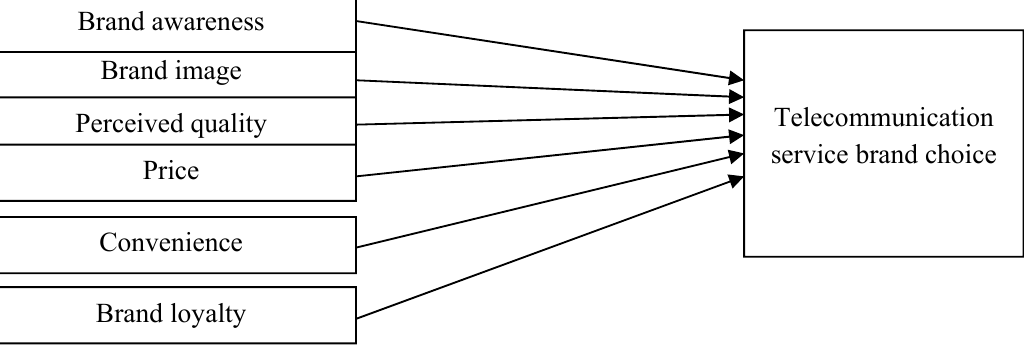
Fig. 1. Conceptual Framework for Key Motives of Consumer Brand Choice (Source: Adapted from: Aaker, 1991; Keller, 2003; Nowlis & Simonson,